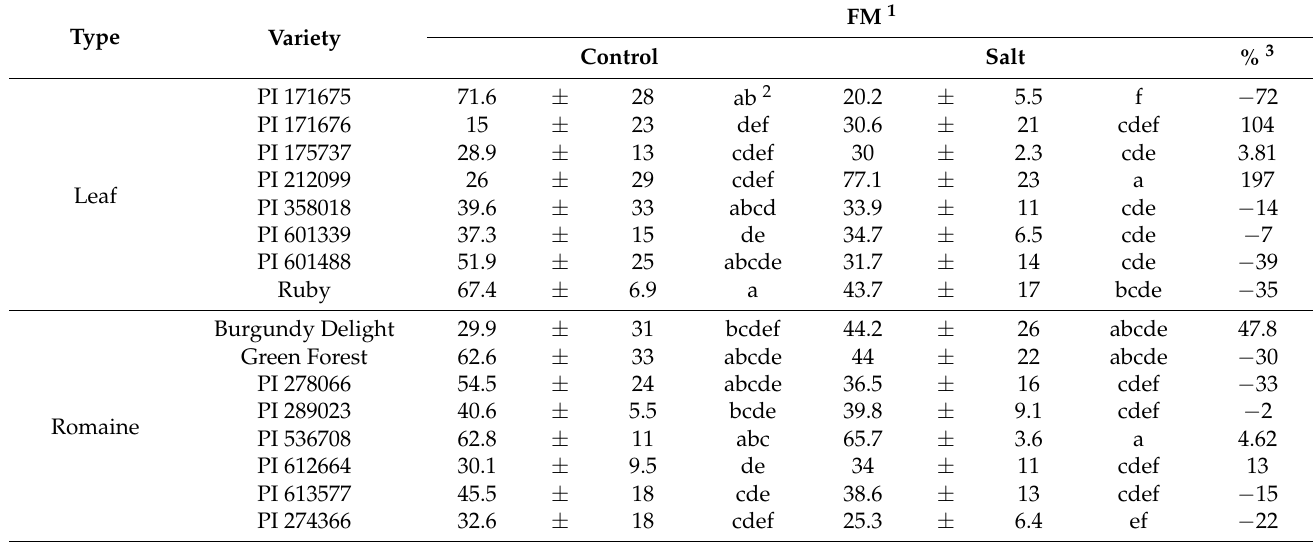
Table 4. Fresh mass (FM) (mean ± standard deviation, n = 6) of leaf- and romaine-type lettuce cultivars grown under control and salt-stress conditions (100 mM) after 42 days of sowing (10 days after salt treatment). Type